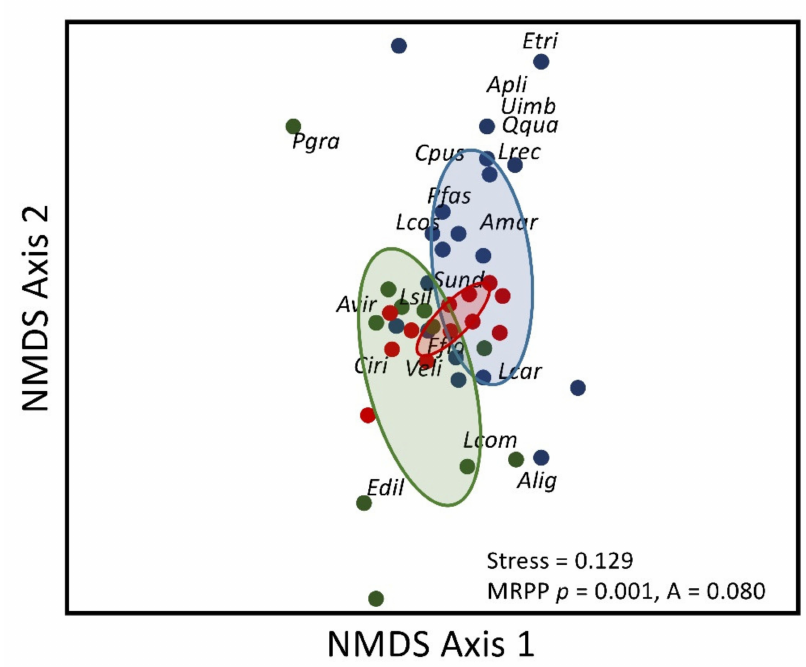
Figure 3. Non-Metric Multidimensional Scaling (NMDS) ordination of study sites in mussel species space. Symbols are timed-searches performed at barriers and taxon scores are presented by taxon abbreviations (First letter of genus and three letters of species; see Table 1). Blue = uncontrolled dams, Red = controlled dams, Green = dam removals. Ellipses represent 95% confidence intervals around the centroid of each data